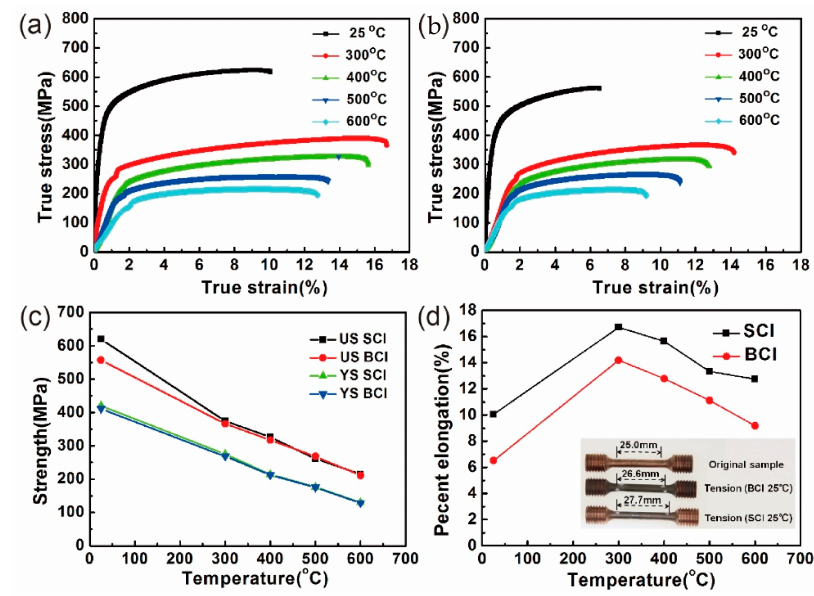
Figure 3. Quasi-static tensile tests of W-30Cu composites: ( a ) true stress–strain curve of the SCI composite; ( b ) true stress–strain curve of the BCI composite; ( c ) tensile strength-temperature curve; ( d ) percent elongation–temperature